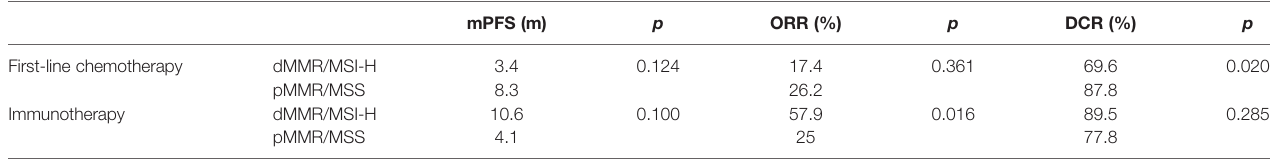
TABLE 5 | The response and progression-free survival of fi rst-line chemotherapy and immunotherapy for dMMR/MSI-H patients. mPFS (m) p ORR (%)